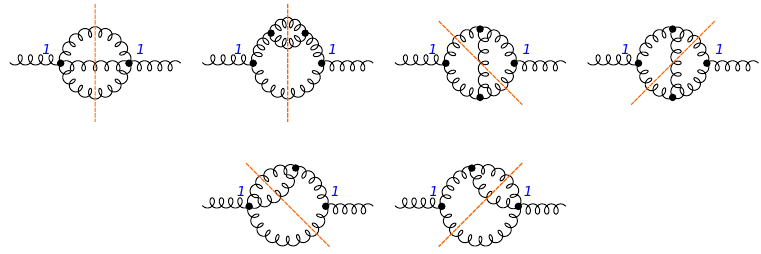
. In each diagram the dashed orange line cuts through all the 11